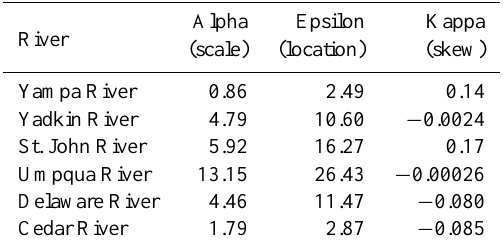
Table 2. Parameters of GEV distribution fit to six river’s annual maximum discharges. This typical outcome of a flood frequency analysis offers little information to help improve student intuition of dominant flood